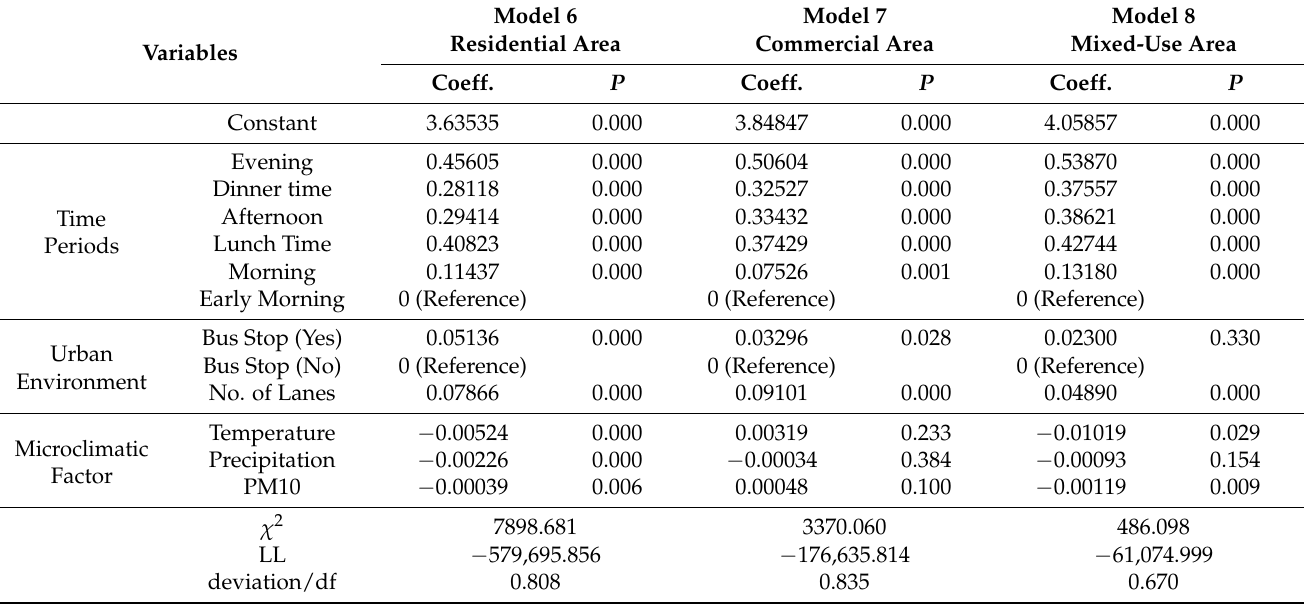
Table 10. Negative binominal regression analysis results by land-use (summer).